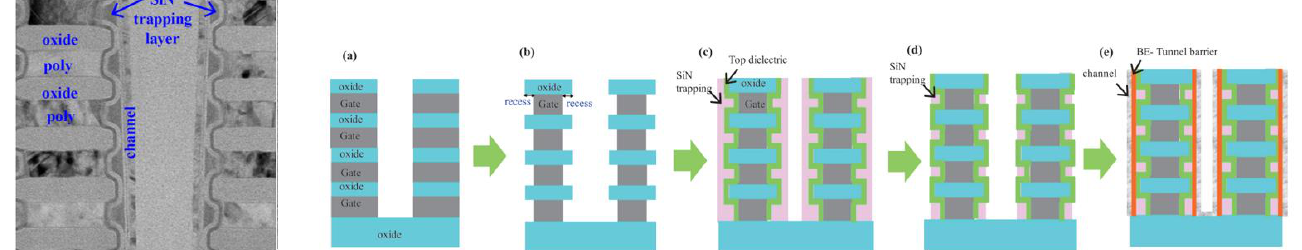
Figure 13. Charge-trap cell with the confined SiN storage layer and the process flow. The SiN storage is successfully separated between cells. The pillar etching diameter needs to be smaller compared to the conventional charge-trap cell. Reprinted with permission from ref. [45], Copyright 2019 IEEE.